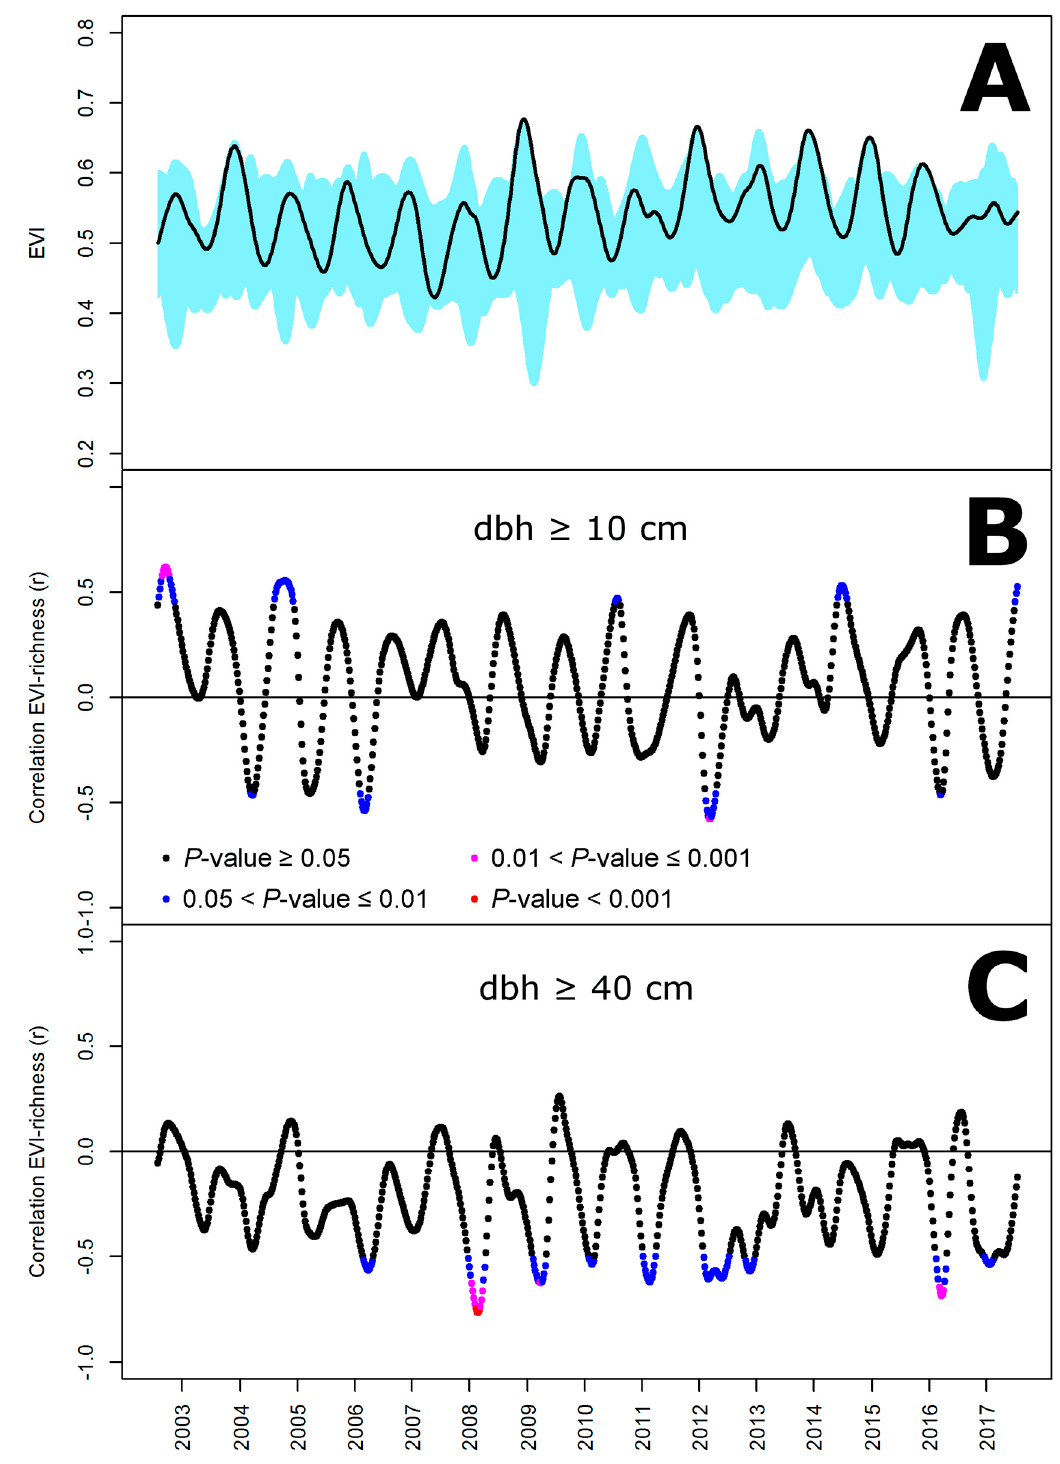
Figure A1. Temporal variation of MODIS EVI in 19 one-hectare plots in New Caledonia ( A ) and in its ability to predict species richness of trees with a diameter at breast height (dbh) above 10 cm ( B ) and 40 cm ( C ). ( A ) The black line represents the mean and the blue shaded area the interval within which plot values are found; ( B , C ) the color set refers to four significance levels of correlation tests.